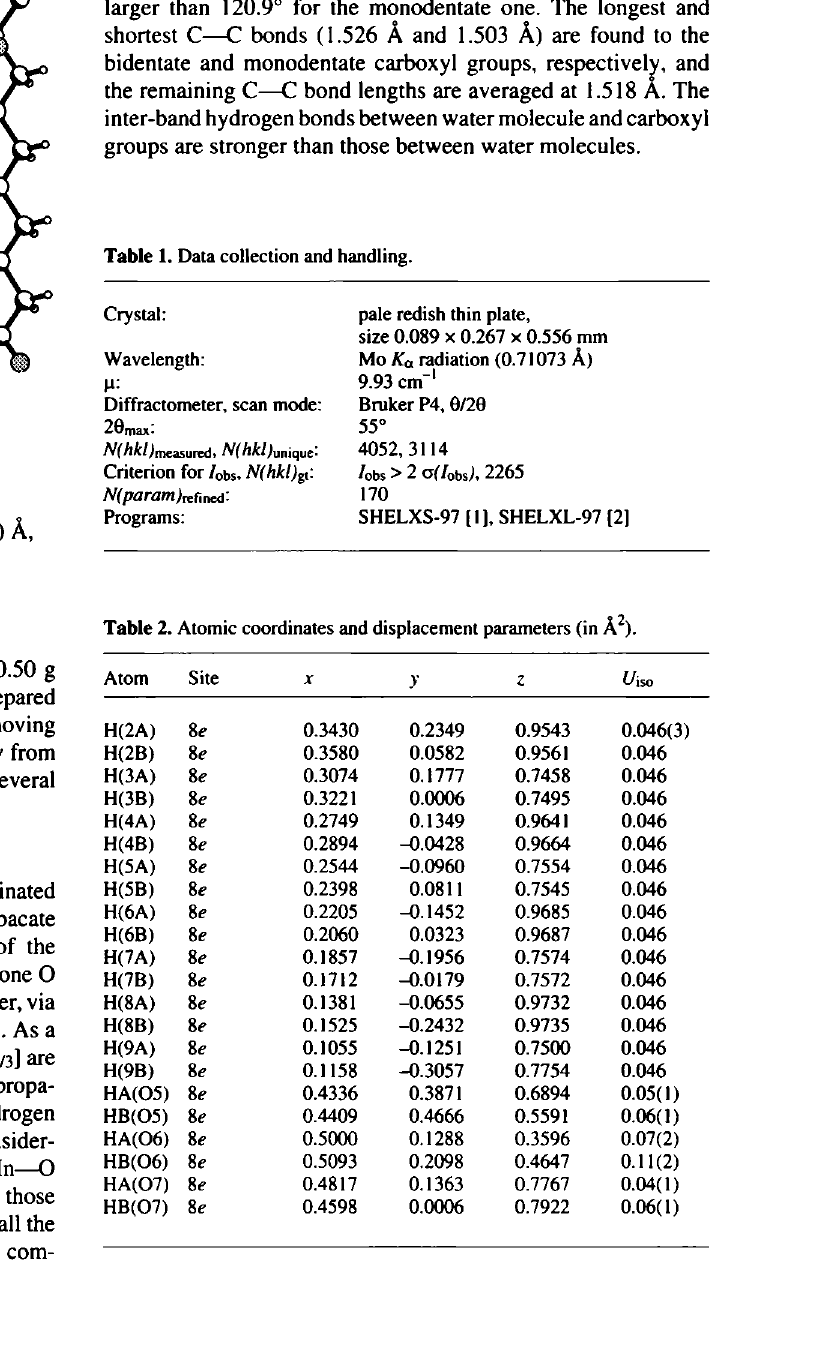
mon plane, from which both bidentate and monodentate carboxyl groups are rotated away by 28.6° and 66.3°. respectively. The C—Ο bond lengths vary over the range 1.251 Ä - 1.265 Ä and the O-C-O angle for the bidentate carboxyl group is 122.6° slightly larger than 120.9° for the monodentate one. The longest and shortest C—C bonds (1.526 Ä and 1.503 Ä) are found to the bidentate and monodentate carboxyl groups, respectively, and the remaining C—C bond lengths are averaged at 1.518 A. The inter-band hydrogen bonds between water molecule and carboxyl groups are stronger than those between water molecules.